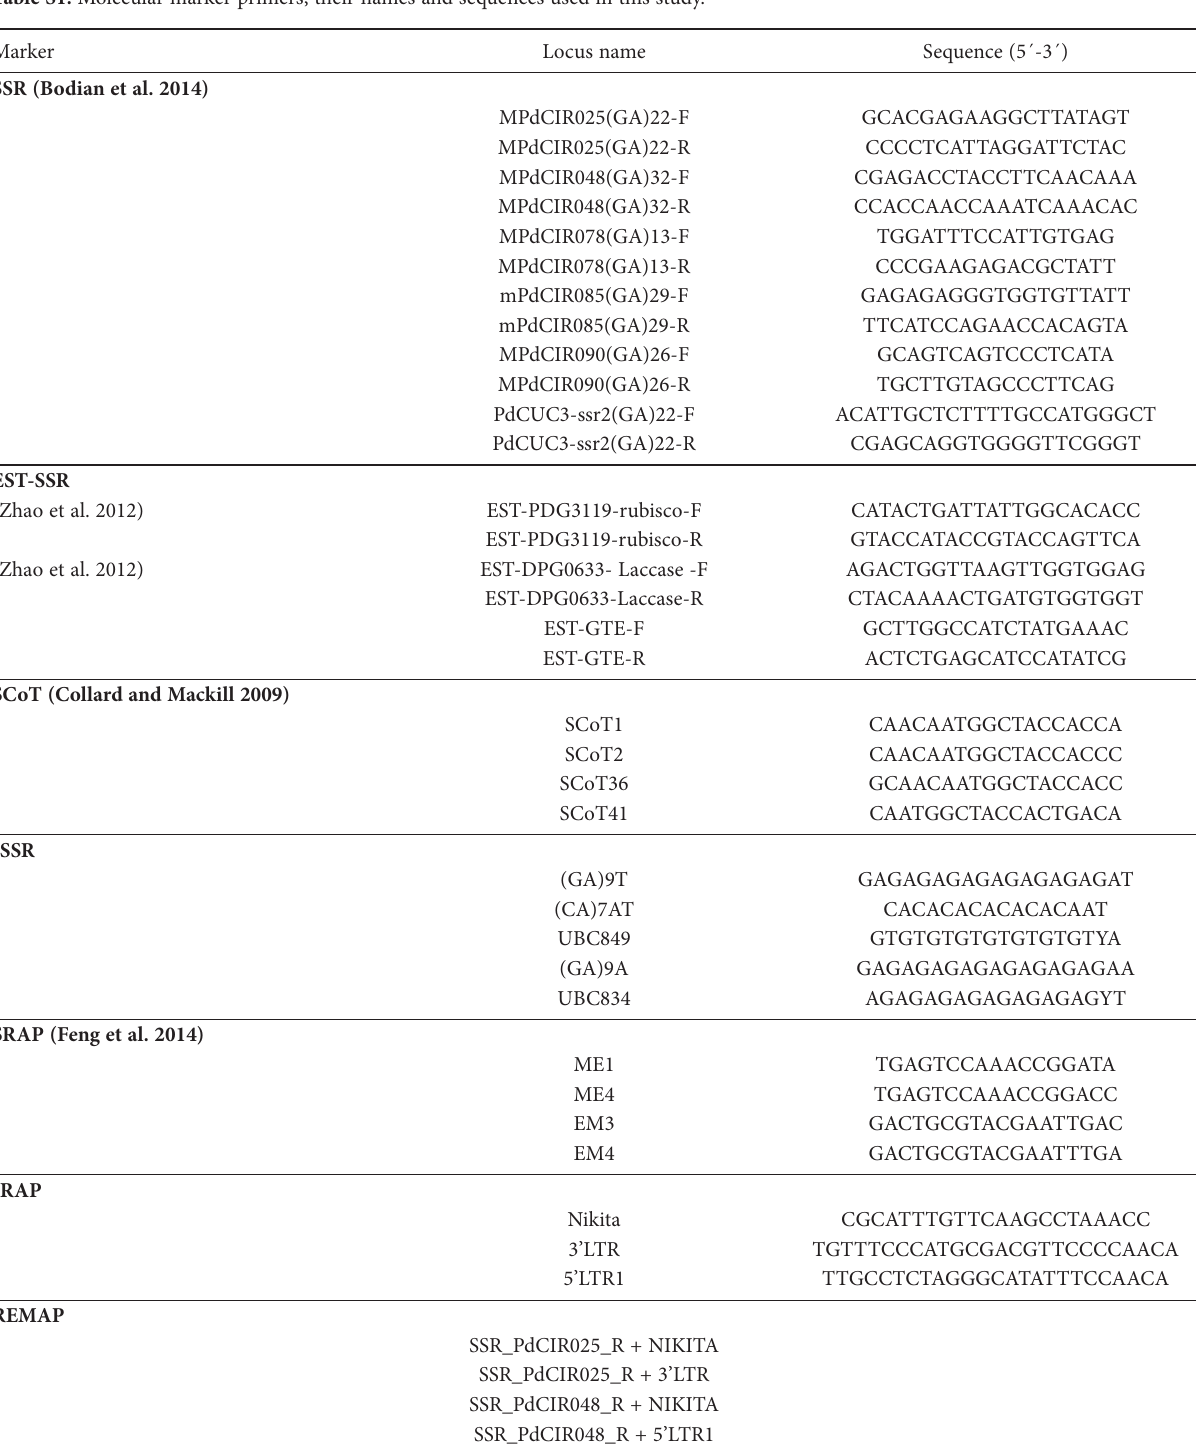
Table S1. Molecular marker primers, their names and sequences used in this